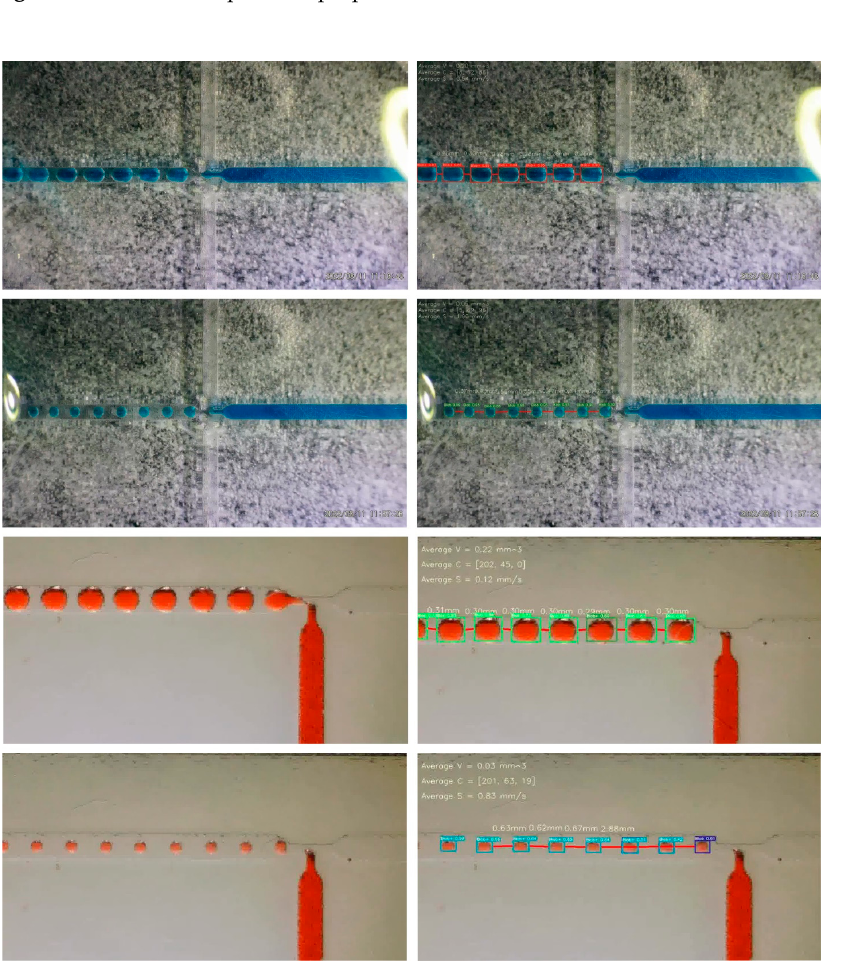
Figure 13. The proposed software toolkit operation for extracting the monodisperse droplets mor ‐ phological and dynamic characteristics based on digital microscope video data streams in microflu ‐ idic synthesis.